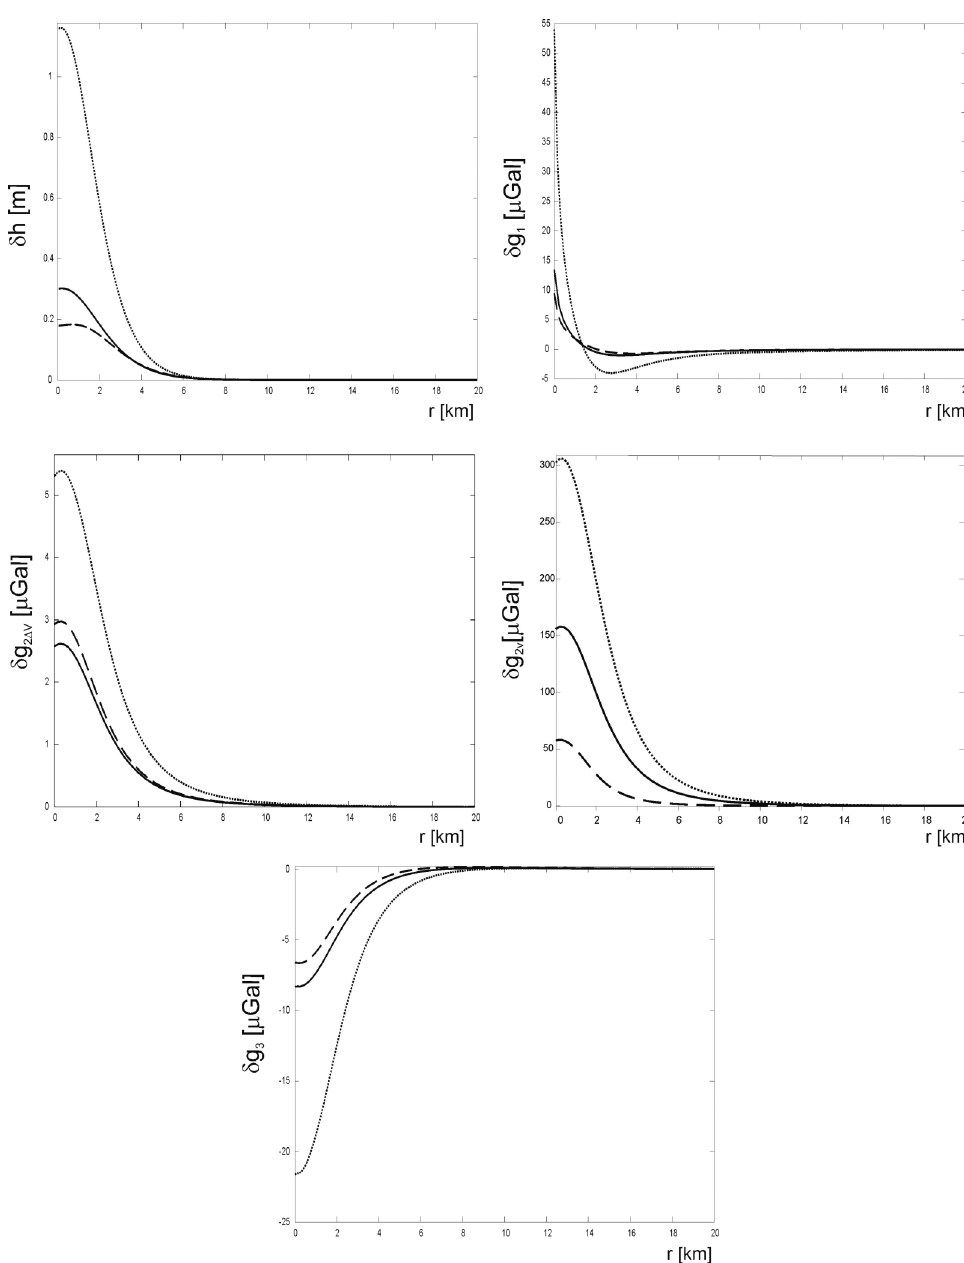
Fig. 10. Numerical solutions for the elevation changes and the δ g 1 , δ g 2 ∆ V and δ g 3 gravity contributions for three source shapes: the SP source (solid line), the VPS source (dashed line) and the HPS source (dotted line). The numerical model takes into account elastic and density heterogeneities of the medium and